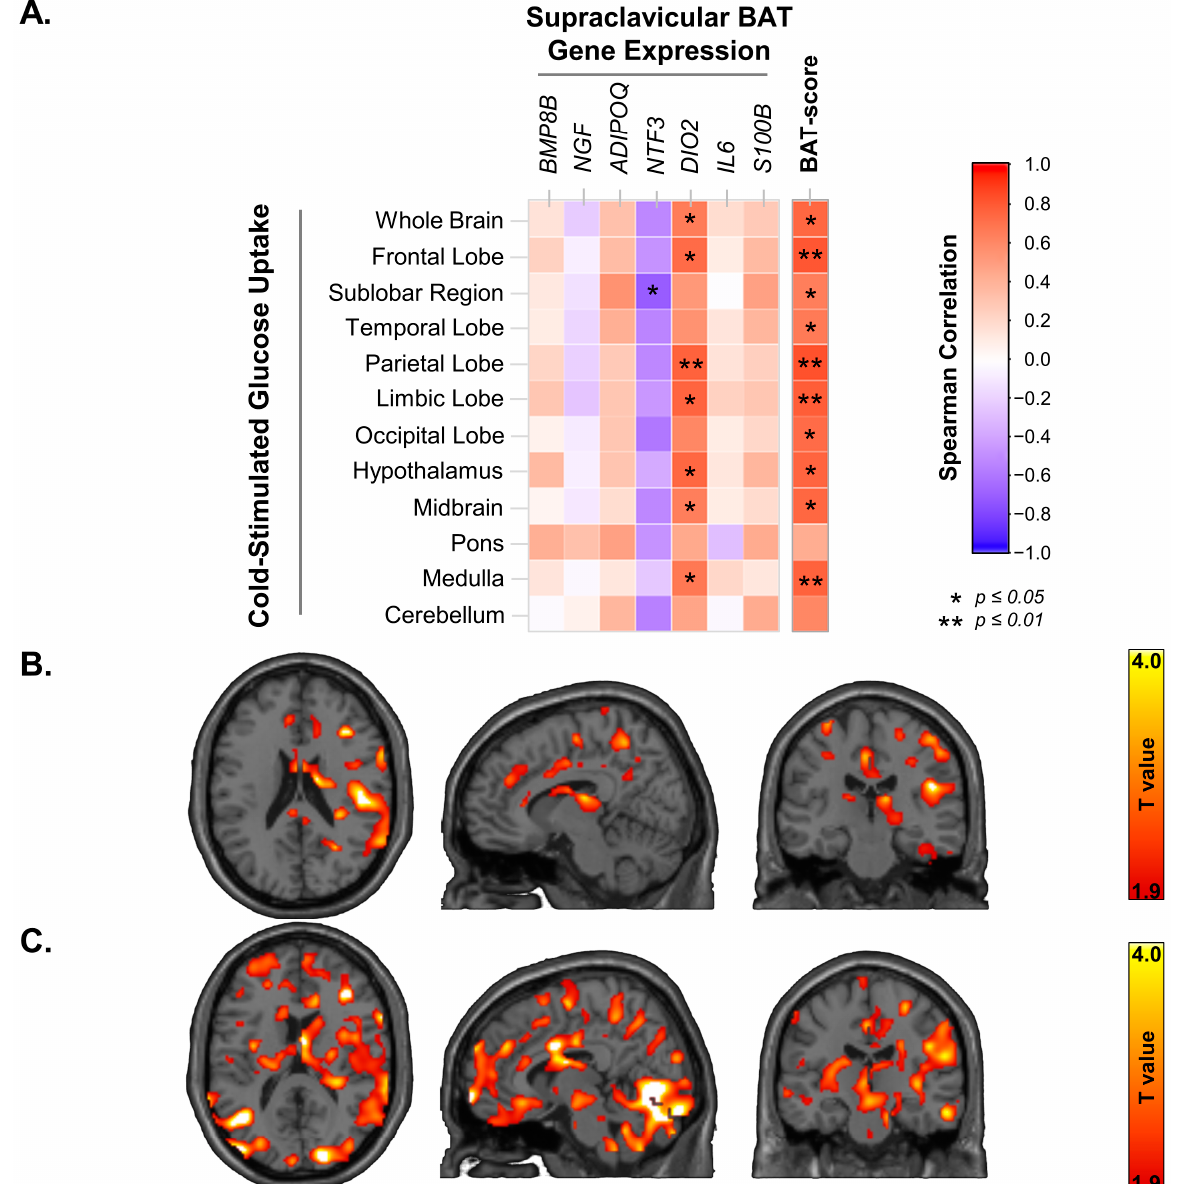
Figure 3. ( A ) The relationship between the expressions of genes in supraclavicular BAT—that may influence brain metabolism via proteins encoded by them—and brain glucose uptake in mild cold stress. The relationship between BAT-probability score—based on the transcriptional profile of supraclavicular BAT sample, and cold stimulated brain glucose uptake. ( B ) Statistical parametric mapping (SPM) images of the association between brain glucose uptake (BGU) during cold conditions and BAT DIO2 expression. p values < 0.05 cluster level; p values < 0.05 voxel level; extend threshold k = 3031 voxels; FDR-corrected. Higher T values denote stronger associations (coloured bar at the side) ( C ) Statistical parametric mapping (SPM) images of the association between brain glucose uptake (BGU) during cold conditions and BAT-probability score. p values < 0.05 cluster level; p values < 0.05 voxel level; extend threshold k = 114 voxels FDR-corrected. Higher T values denote stronger associations (coloured bar at the side).